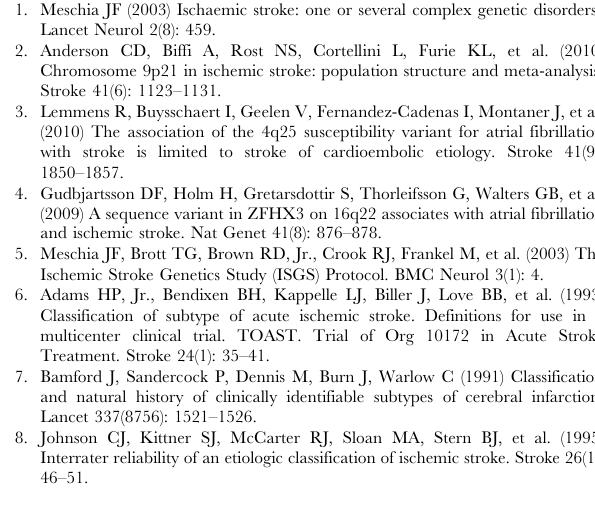
Figure 1. Fixed-effects meta-analysis results for all SNPs passing quality control in both the ISGS/SWISS and BRAINS cohort. Orange points denote loci passed forward to risk profile analyses, with p-values , 1E-5 from fixed-effects